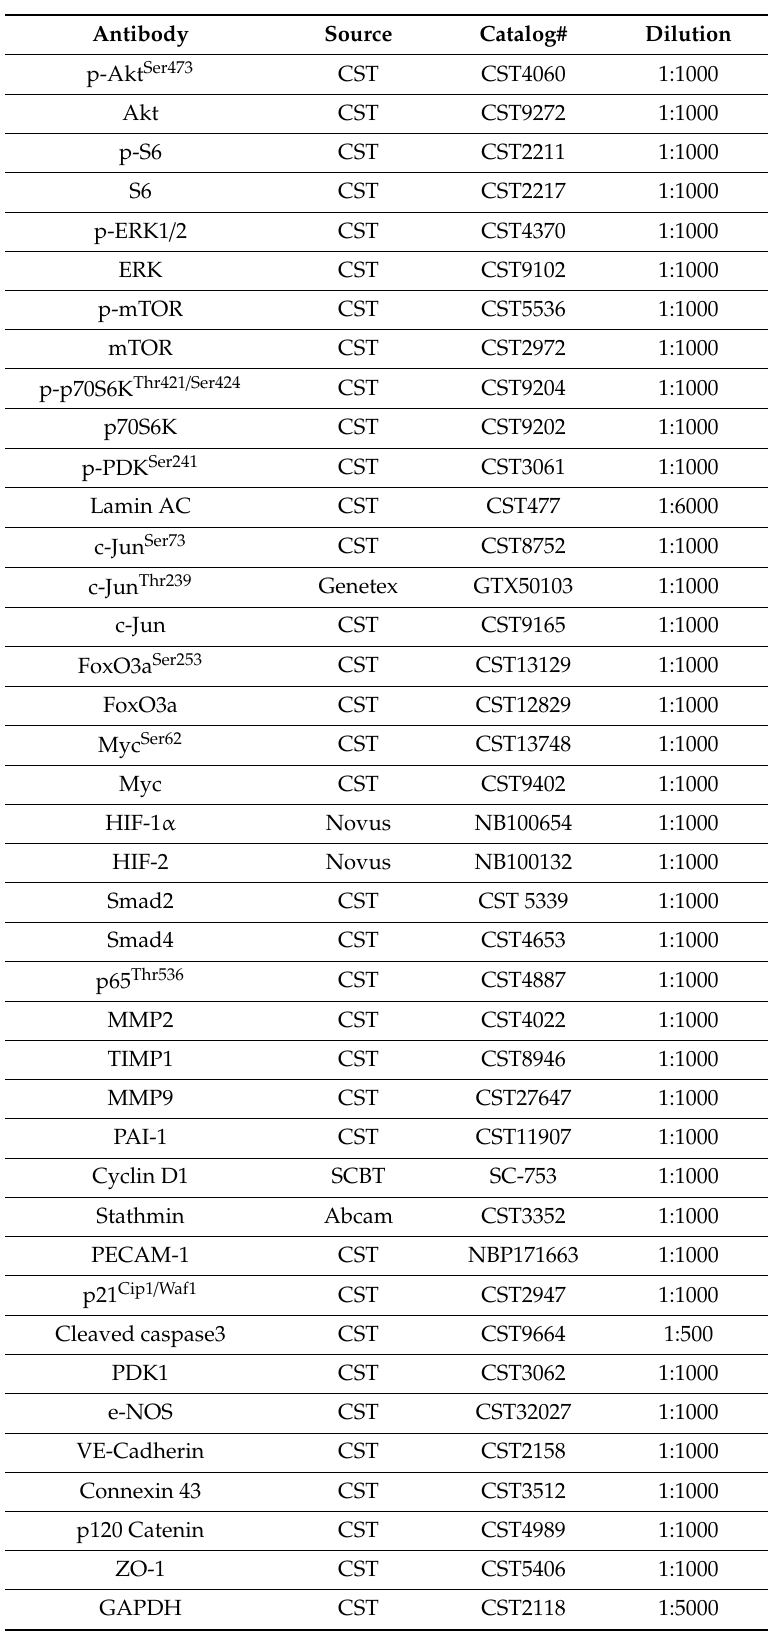
Table A1. Sources of